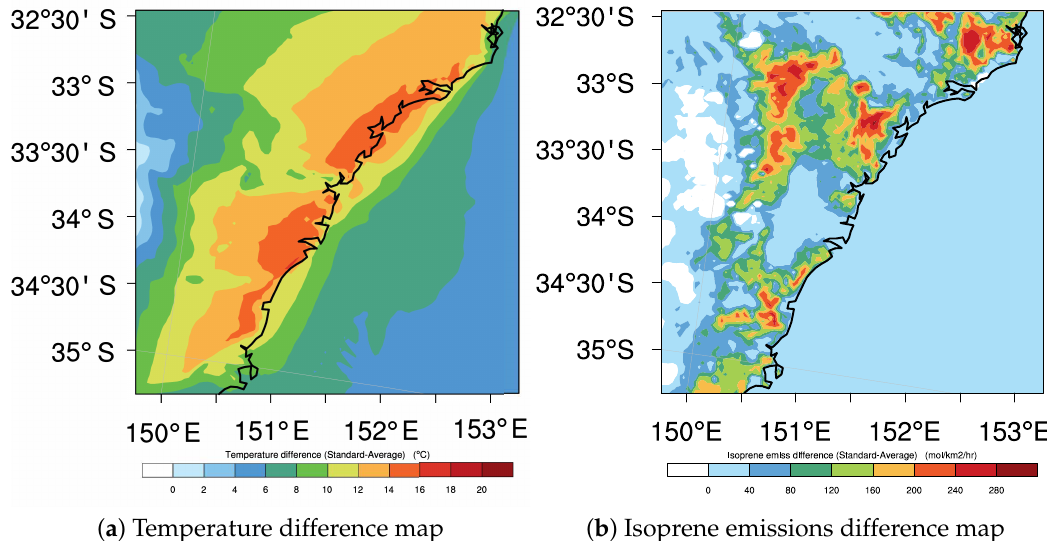
Figure 11. Maps of difference between standard and average temperature (STD_T-AVG_T) and isoprene emissions (STD_E-AVG_E) at 3:00 p.m. on 18 January